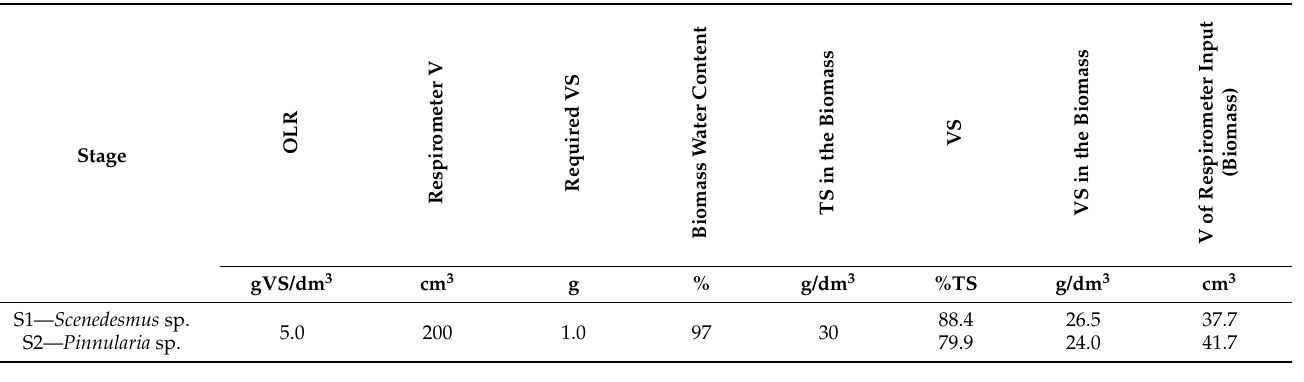
Table 6. Quantities and volumes of microalgal biomass injected into the